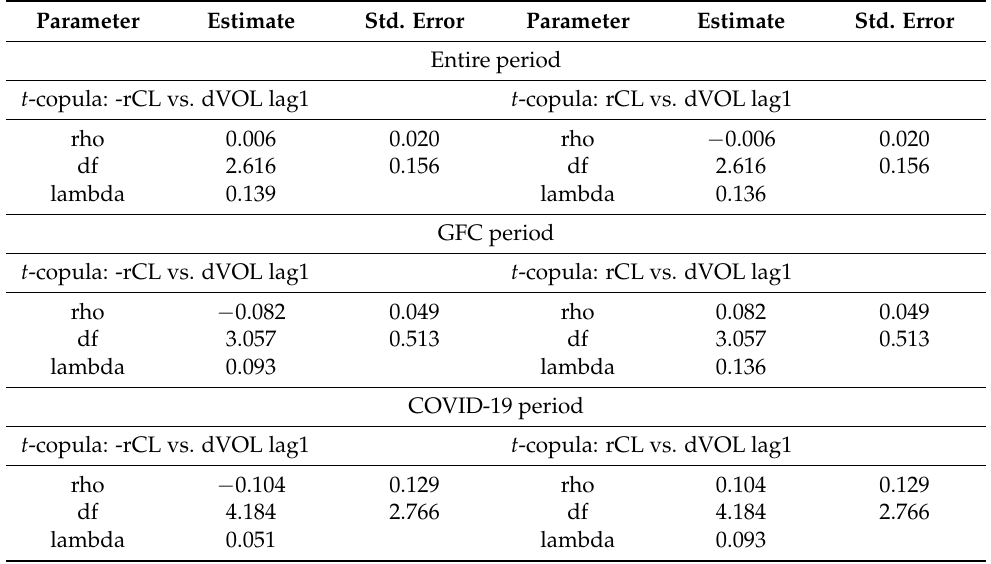
Table 4. Copula parameters and tail dependence coefficient for Crude Oil Future Contract returns (rCL) and one-day lagged changes in the volatility of Crude Oil Future Contract returns (dVOL) in the entire period and